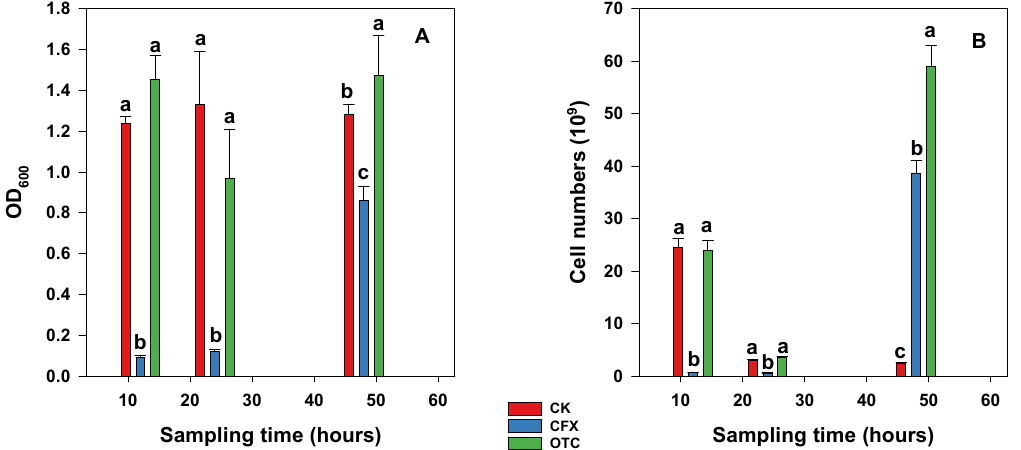
the net OD 600 value and cell numbers increased up to 0.86 ± 0.07 and 38.65 ± 2.39 × 10 9 after 48 h cultivation. Similar dynamic change behavior for the net OD 600 value and cell number was also found for the treatment with OTC.